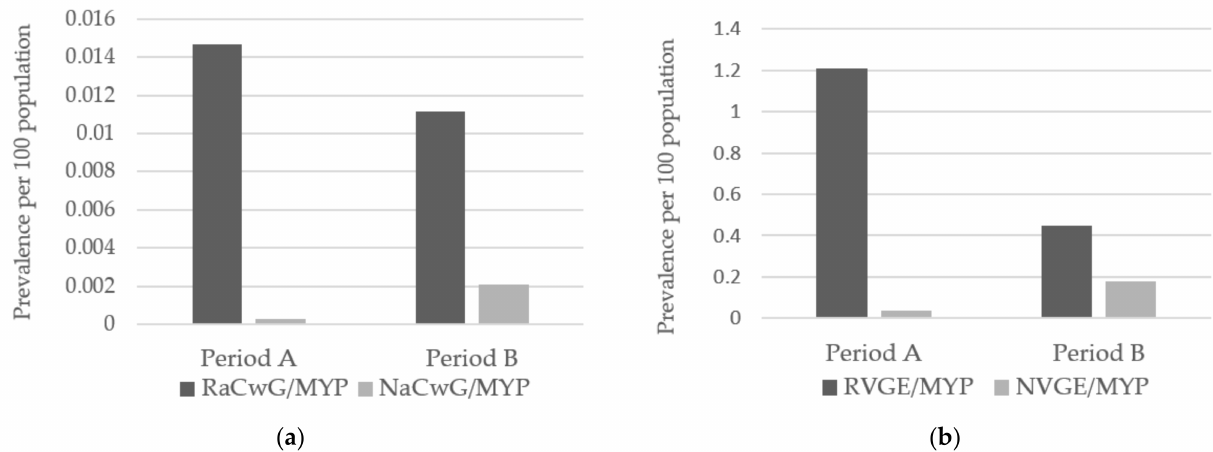
Figure 2. Between-period comparison of the prevalence of RVGE, RaCwG, NVGE and NaCwG. ( a ) Comparison of the RaCwG prevalence per 100 comprising the MYP (odds ratio: 0.759, p < 0.001) and NaCwG patients per 100 comprising the MYP (odds ratio: 115.311, p < 0.001). ( b ) Comparison of the prevalence of RVGE (odds ratio: 0.369, p < 0.001)